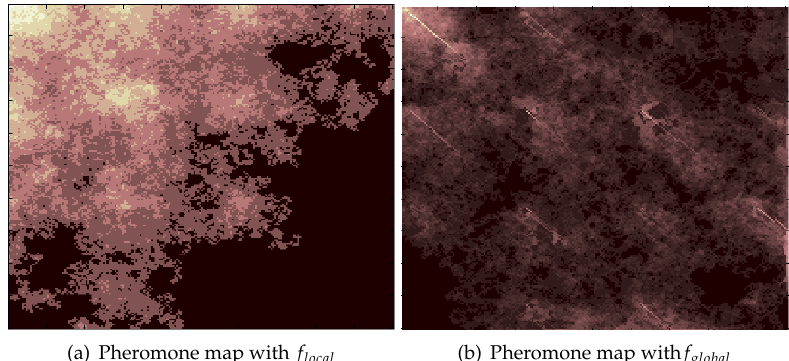
Figure 7. Typical pheromone maps with behavior law f local and f global . The pheromone maps are shown with a grayscale map, indicating the density of repellent pheromone. The density of the pheromone is higher in the lighter region and lower in the darker region. The pheromone density is 0 in the black region. We want most areas to be visited by robots, but not repeated many times; ( a ) is not perfect because it has a large black part, representing regions that have never been visited. It also has a large part that is extremely white, indicating that these regions have been visited repeatedly, which is a duplication of label; ( b ) is better because almost the whole AOI is covered with a layer of light white, indicating that most parts have been visited, and not repeated over and over